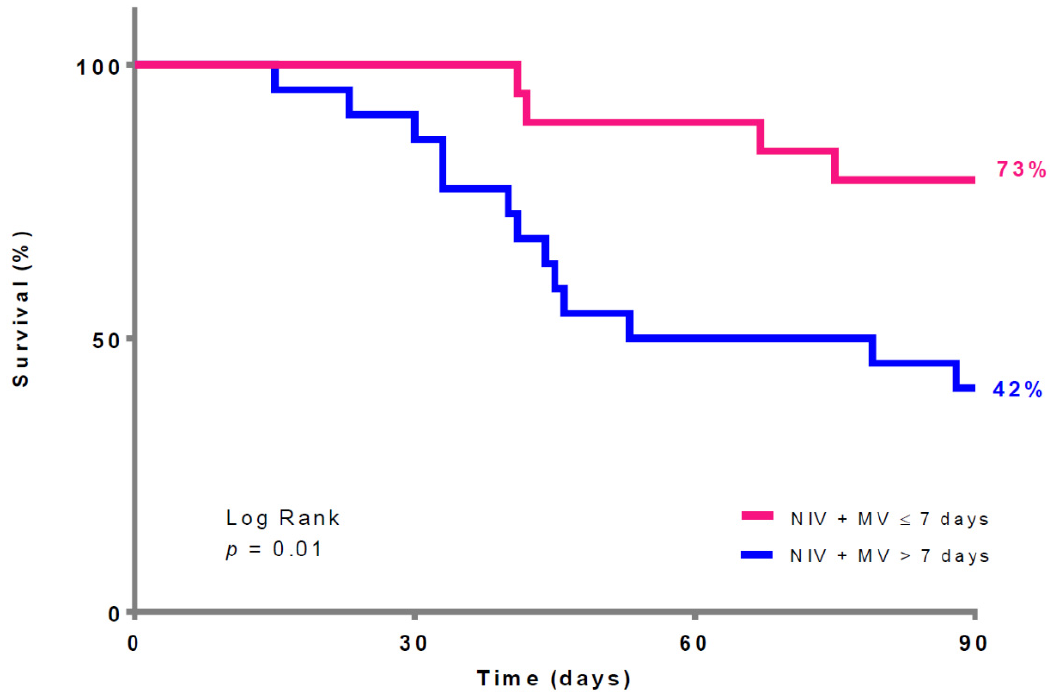
Figure 2. 90-day survival according to the time between non-invasive ventilation + mechanical ventilation and ECMO implantation. ECMO: extracorporeal membrane oxygenation; NIV: non-invasive ventilation; MV: mechanical ventilation.